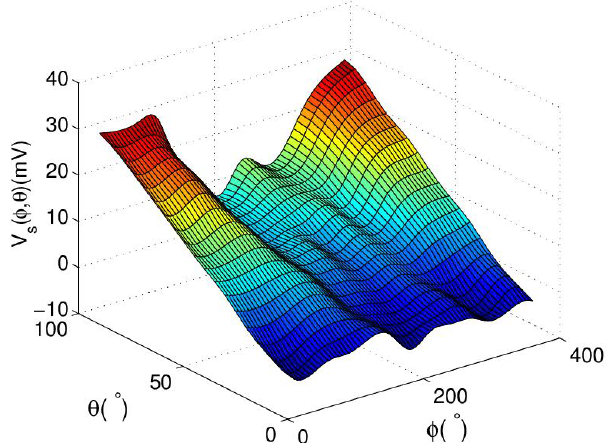
Figure 11. 2D interpolation of g ( ϕ , θ